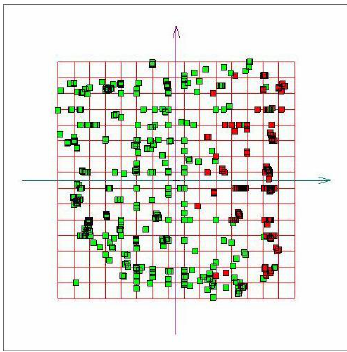
Figure 14. extension of elastic map for 12-dimensional attribute space when diagnosing